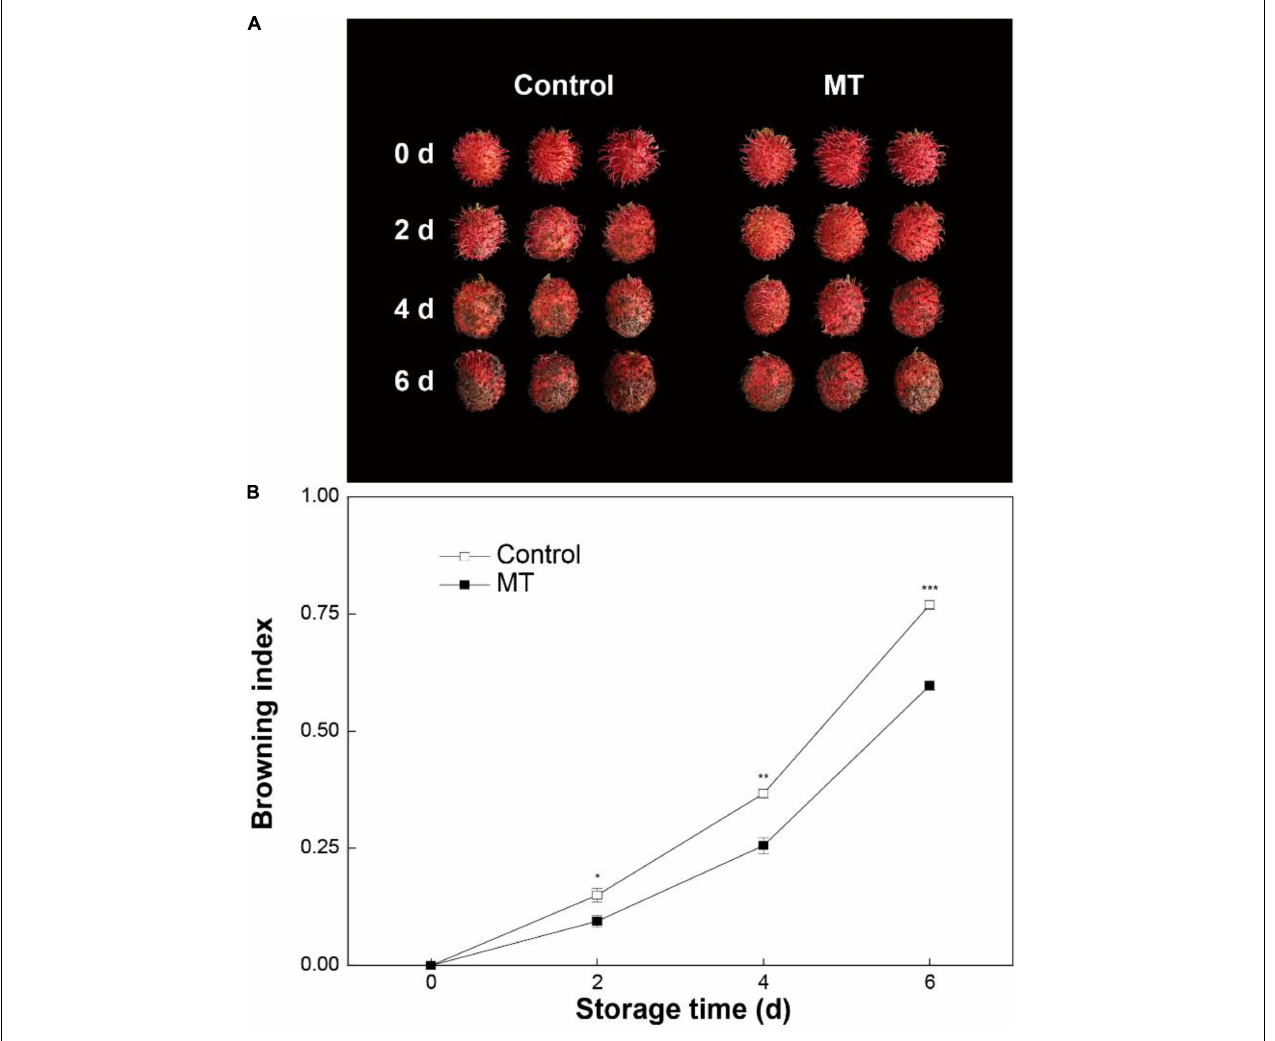
FIGURE 1 | Appearance (A) and browning index (B) in “Baoyan 7” rambutan fruit during storage at 25 ◦ C after treatment with 0.125 mmol L − 1 melatonin (MT) or water (control). The vertical lines represent the SE of triplicates while the asterisks indicate a significant difference between the MT group and the control group at the same day (* p < 0.05, ** p < 0.01, and *** p <